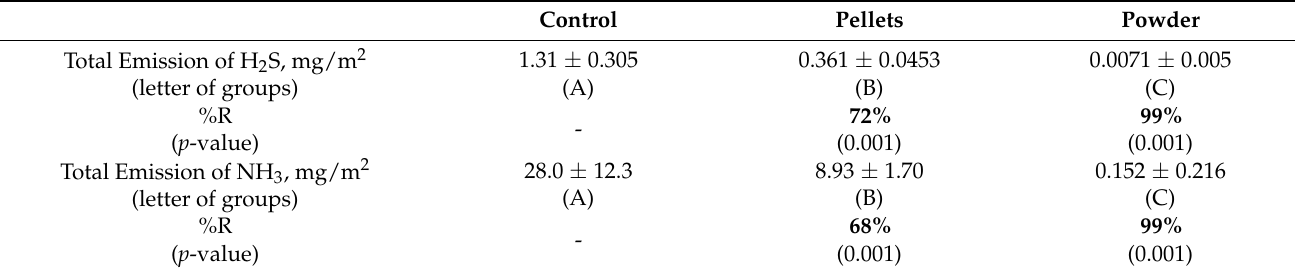
Table 2. The total emissions of H 2 S and NH 3 ( ± standard deviation) and % reductions (%R) during the 3 h agitation of swine manure averaged for n = 3 trials. Statistical significance is reported as ( p -values) and bold font. The letter of the groups resulting from the ANOVA indicates significant differences.